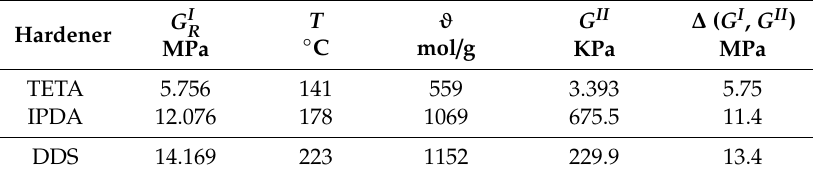
Table 4. Calculated network densities for the matrix polymers.